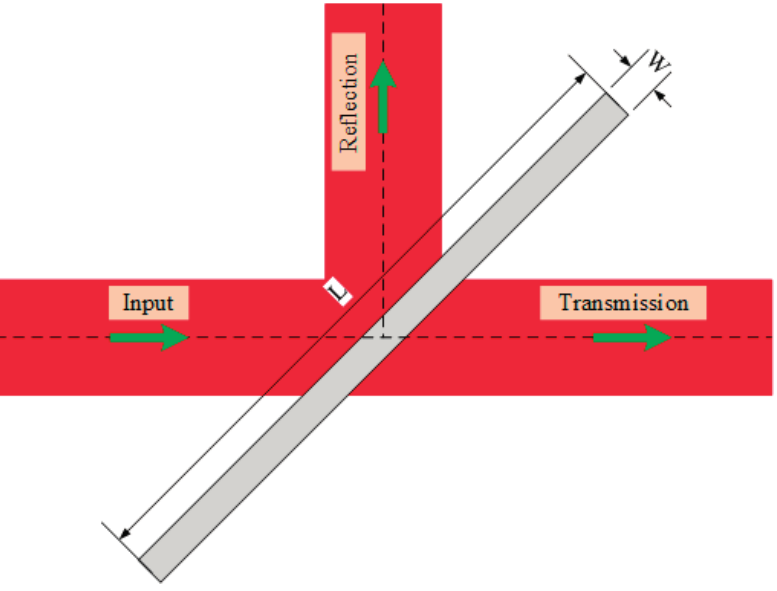
Figure 6. T-shaped branch geometry of SOI rib waveguide with large cross